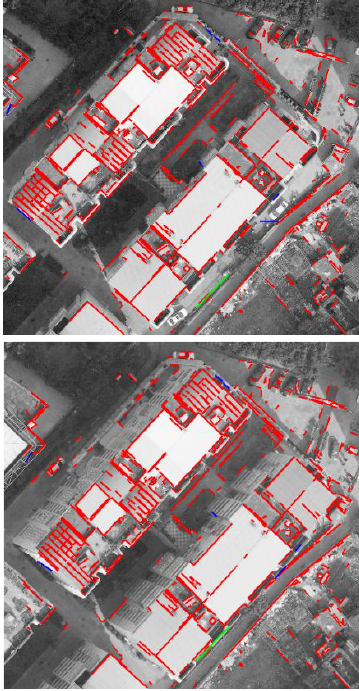
Fig. 11. Patch #1 - Red lines are correct matches, blue lines are wrong matches, and green lines are line endpoints